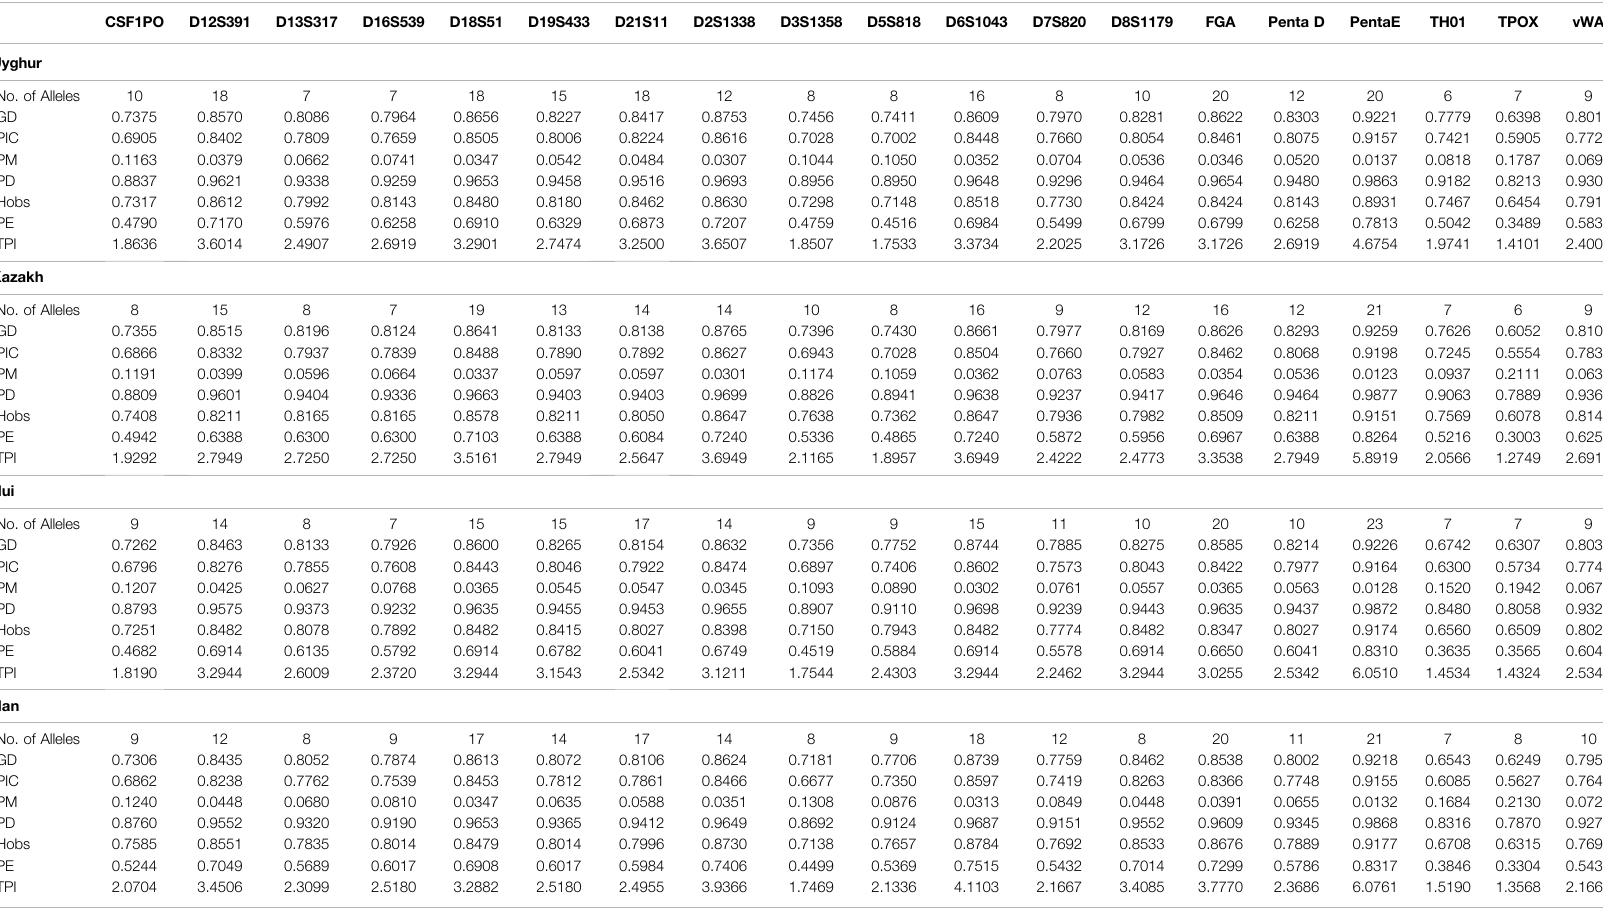
TABLE 1 | Forensic parameters of the 19 autosomal STR loci in four (Uyghur, Kazakh, Hui and Han) populations residing in Xinjiang Uyghur Autonomous Region (XUAR) in China.